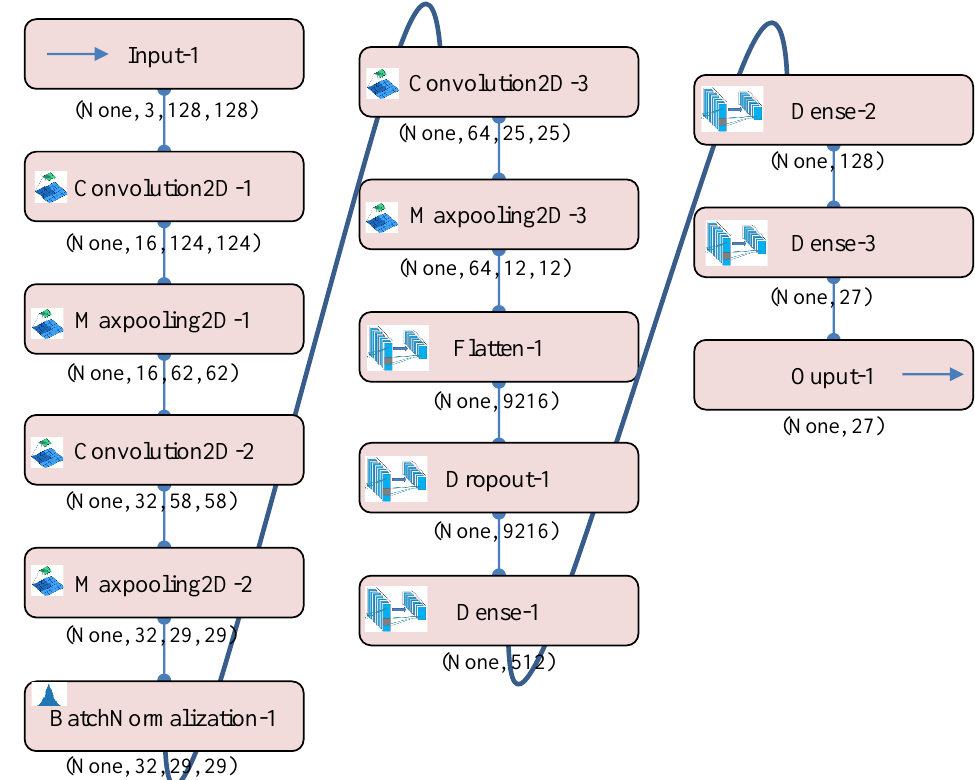
Figure 4. Deep Neural Network for recognizing hand gestures for numbers ‘0’ to